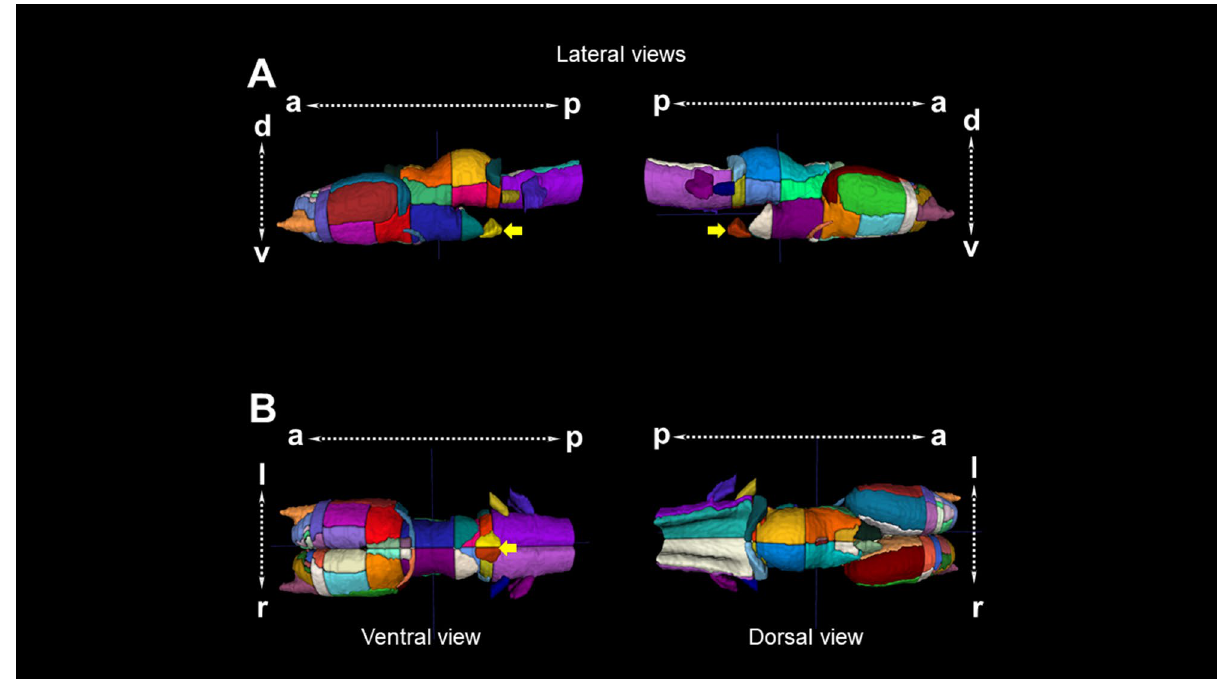
Figure 1. 3D reconstruction of the brain of Ambystoma mexicanum employing MRI. ( A ) Lateral views from the left and right sides of the complete 3D reconstruction created from our template. ( B ) Ventral (left) and dorsal (right) views of the complete 3D reconstruction. Every reconstruction shows each region in a different color when manual delineation was possible. Yellow arrows denote the pituitary